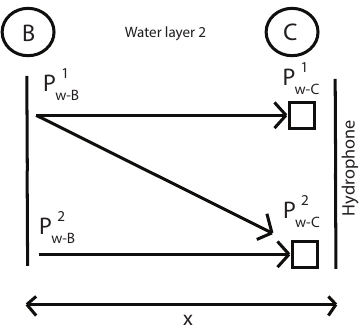
Figure 5. Determination of the β parameter and geometric attenuation in water layer 2 without specimen.